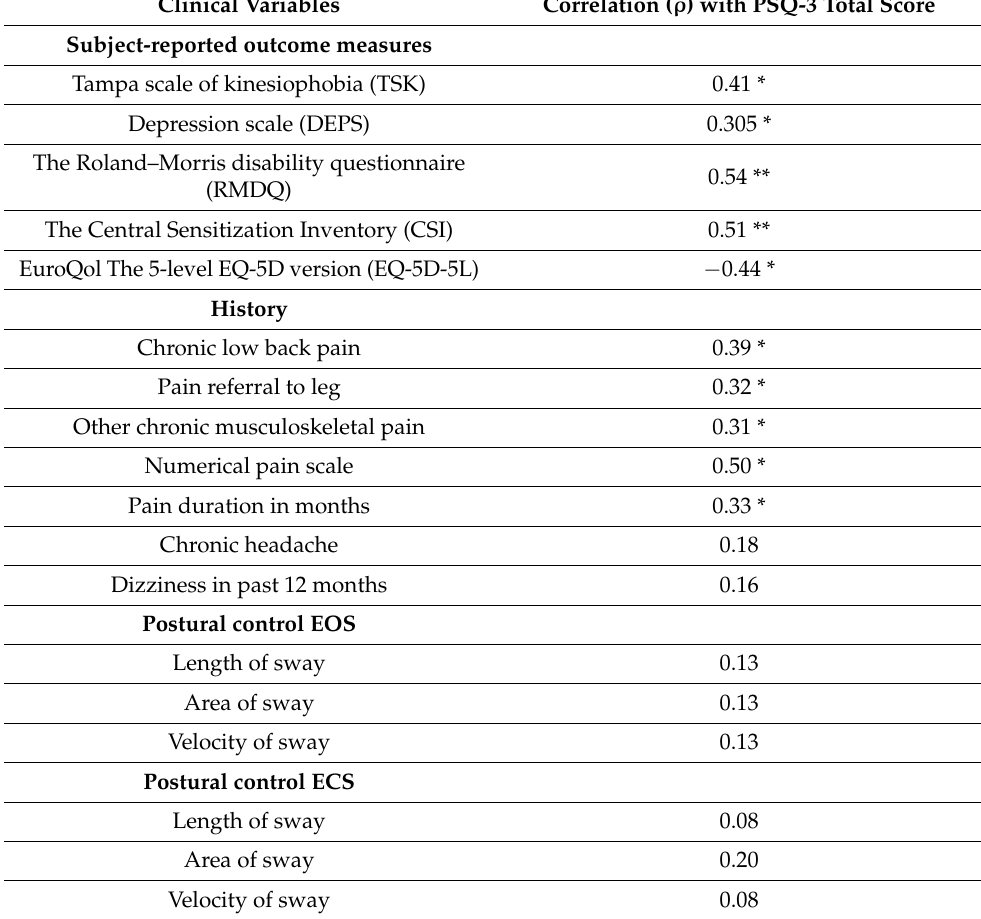
Table 3. Correlations between total PSQ-3-FI scores and subject-reported outcome measures, history, and postural control test parameters ( n =